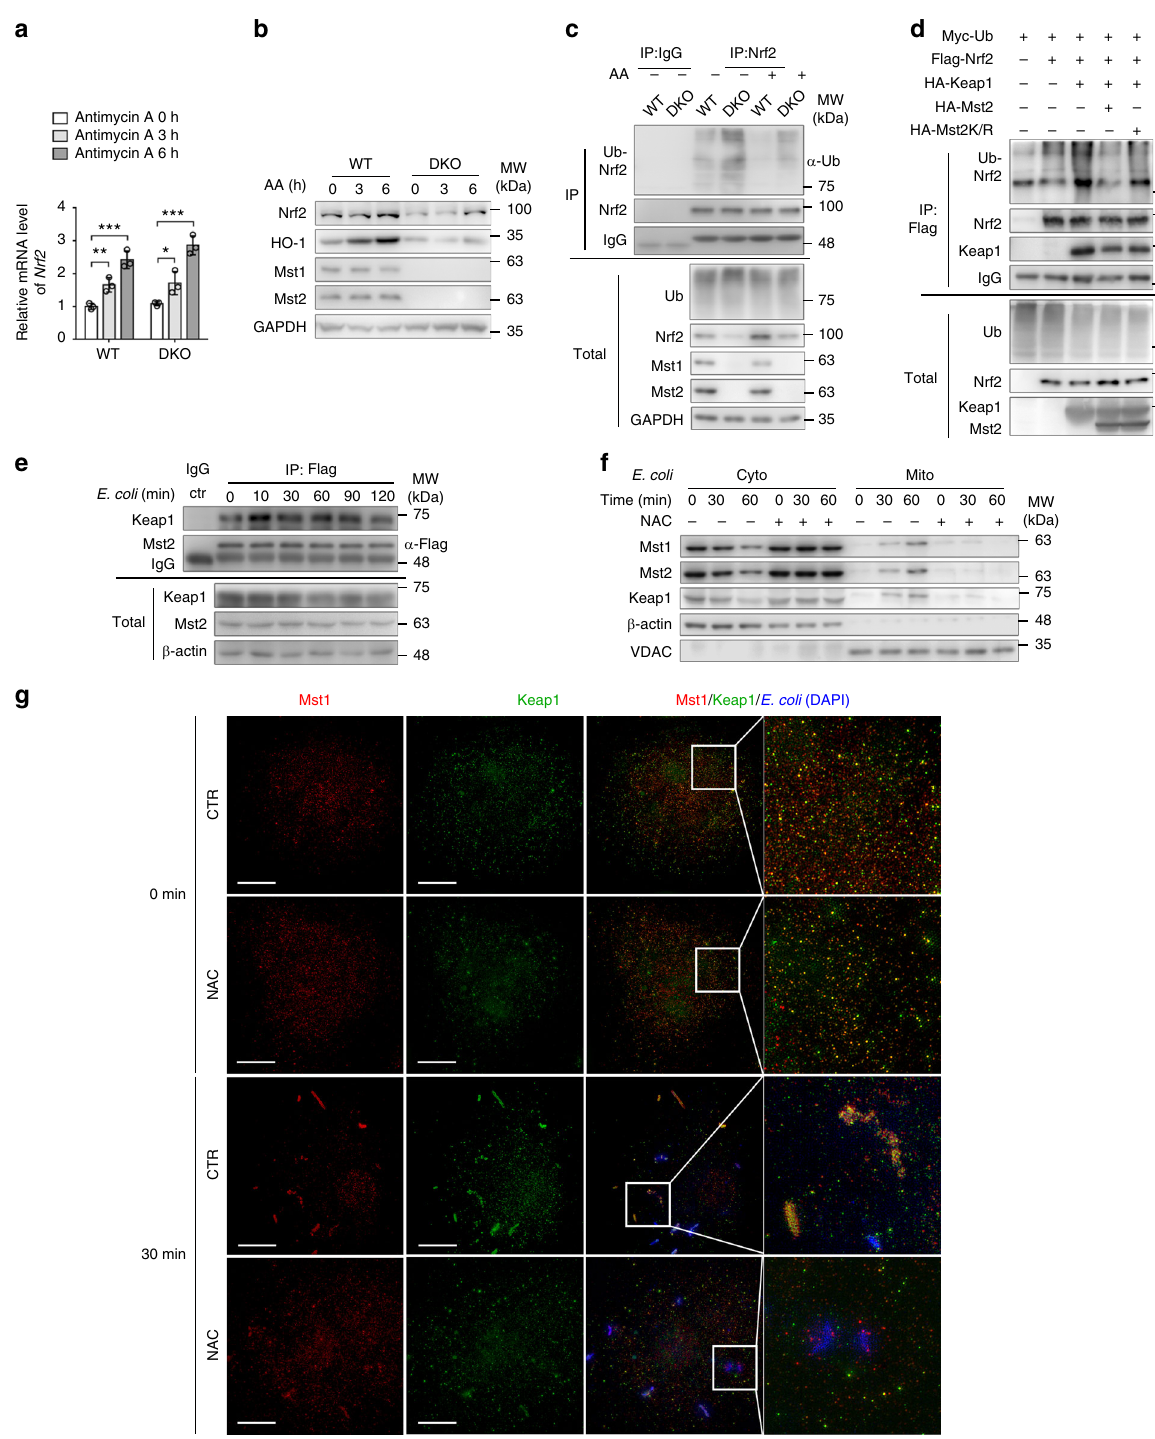
Fig. 5 Mst1/2 downregulates Keap1-mediated ubiquitination of Nrf2. a , b RT-qPCR analysis of the mRNA levels of Nrf2 ( a ) and immunoblot analysis of Nrf2, HO-1, Mst1, Mst2, and GAPDH ( b ) in Mst1 fl / fl Mst2 fl / fl (WT) and Mst1 fl / fl Mst2 fl / fl Lyz -Cre (DKO) BMDMs treated with 10 μ M antimycin A (AA) for indicated times. * P < 0.05, ** P < 0.01, *** P < 0.001, compared with the control sample (Student ’ s t test, n = 3, experimental replicates). c Immunoblot analysis of Nrf2 ubiquitination in total lysates (bottom) and anti-IgG or anti-Nrf2 immunoprecipitates (IP, top) of WT and DKO BMDMs treated with or without antimycin A, probed with anti-ubiquitin ( α -Ub) and antibodies to Nrf2, Mst1, Mst2, and GAPDH. d Immunoassay of the ubiquitination of Nrf2 in anti-Flag IP (top) and total lysates (bottom) of 293T cells expressing various combinations (above lanes) of Myc-tagged Ub, Flag-tagged Nrf2, HA-tagged Keap1, Mst2 or Mst2K/R, and Myc-tagged Ub. e Immunoblot analysis of Keap1 and Mst2 in anti-IgG or anti-Flag IP (top) and total lysates (bottom) of WT BMDM cell line stably expressing Flag-tagged Mst2 infected with E. coli (MOI: 100) for indicated times. f Immunoblot analysis of Mst1, Mst2, β -actin, and VDAC in the cytoplasmic (Cyto) and mitochondrial (Mito) fractions of WT BMDMs pretreated with or without NAC and infected with E. coli (MOI: 100) for indicated times. g SIM of the co-localization of Mst1 (red) and Keap1 (green) in WT BMDMs treated with or without NAC and infected with E. coli (blue) for 30 min; ×16 magni fi cation of areas outlined in the main images are shown next to the main images. Scale bars, 20 μ m. Data are from one experiment representative of three independent experiments with similar